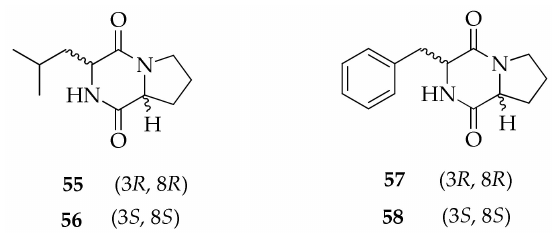
Figure 13. Structures of diketopiperazines.